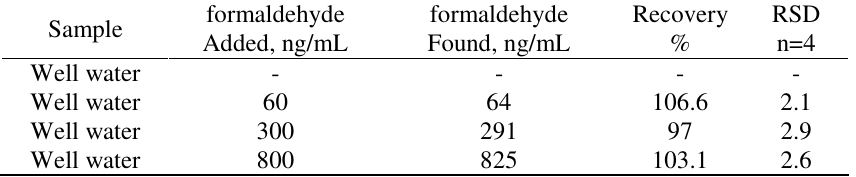
Table 2. Determination of formaldehyde in synthetic